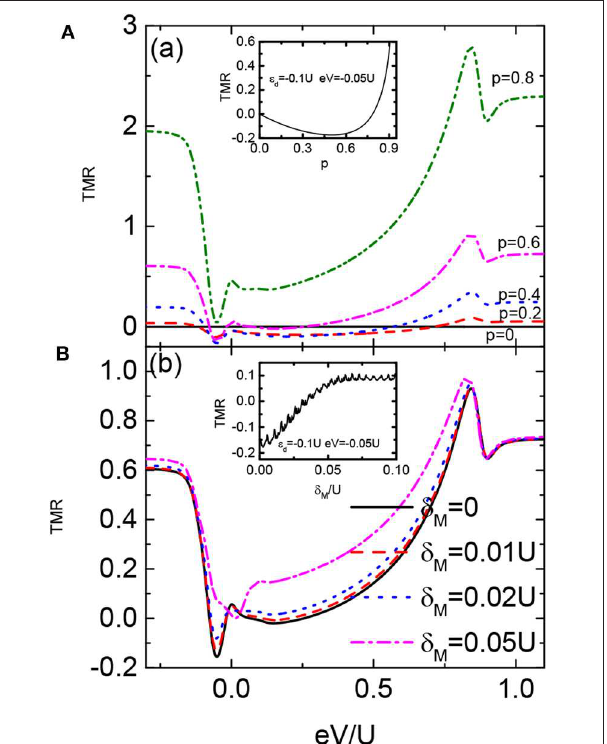
FIGURE 4 | TMR as a function of the bias voltage for different values of spin polarization of the leads p in (A) , and direct overlap between the MZMs δ M in (B) . The insets in (A,B) are the TMR varying with the p and δ M , respectively. Other parameters are as in Figure 2